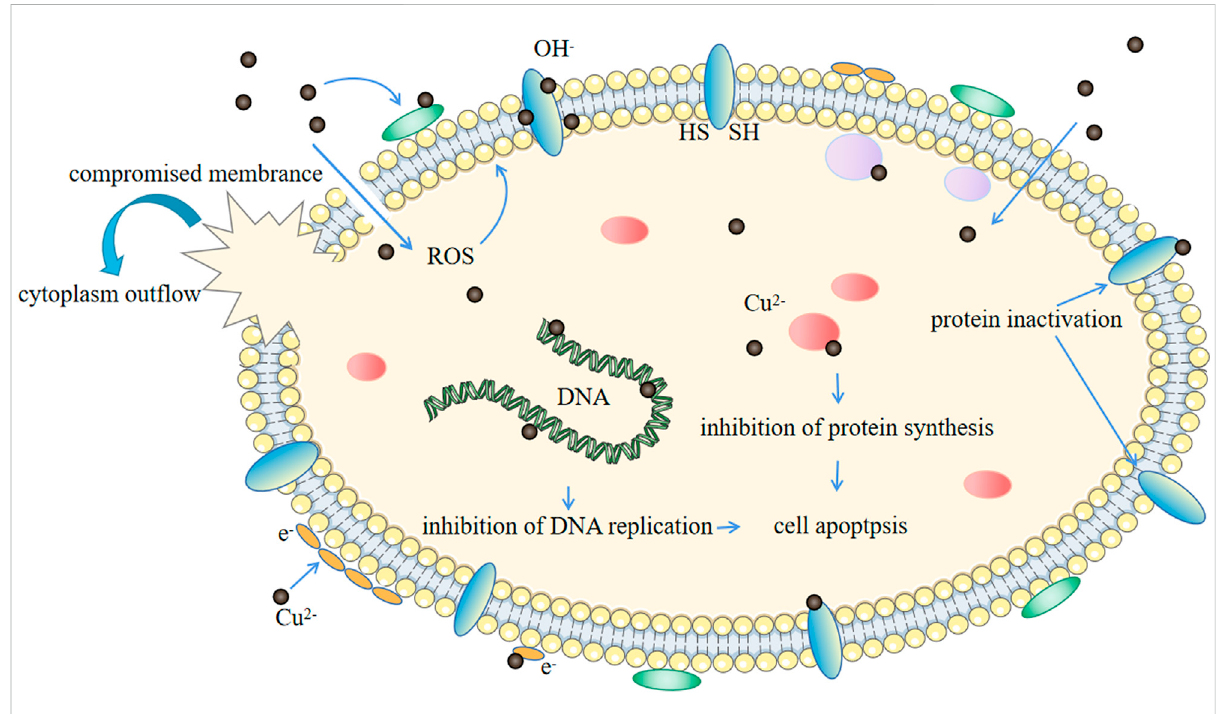
FIGURE 1 Schematic representation of the hypothetical scenario for the antibacterial mechanism of Cu 2+